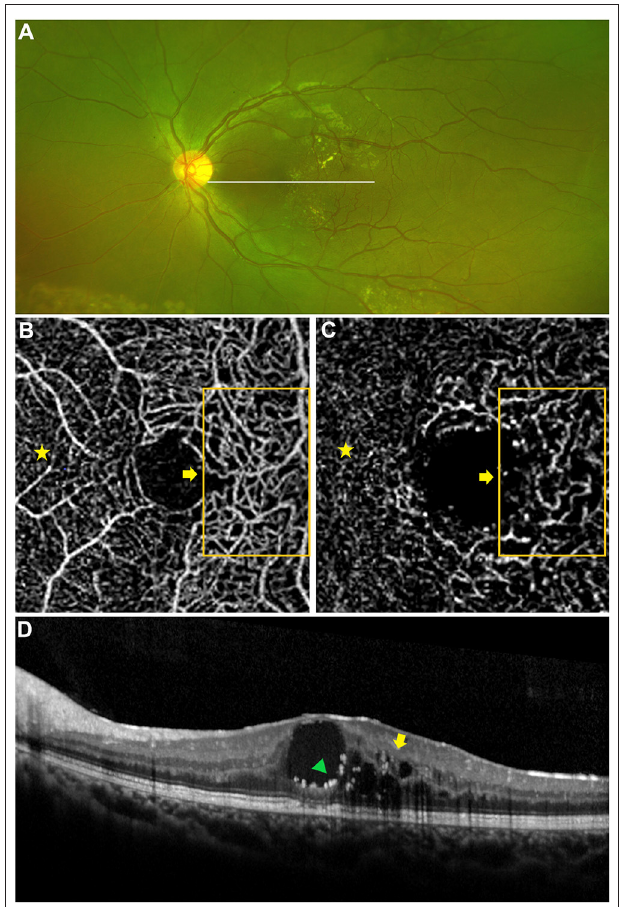
FIGURE 2 | Macular capillary abnormalities in eye with macular edema. A 9 years old boy with Coats’ disease presented as concomitant macular edema (edema combined with exudation). Yellow exudates in the macular region on widefield fundus photography (A) and intraretinal hyporeflective intraretinal cystoid spaces (yellow arrow) combined with intraretinal hyperreflective exudates (green triangle) on OCT imaging (D) . Telangiectasia in the SCP and DCP were detected via OCTA [ (B,C) 3 × 3mm], these abnormal capillaries were located in the temporal region of the macula [ (B,C) orange boxes and yellow arrows], which presented as more dilated microvascular structures in contrast to the capillaries in the nasal region of the macula (yellow stars), in correspondence to the location of macular lesion on OCT imaging [ (D) yellow arrow, green triangle].